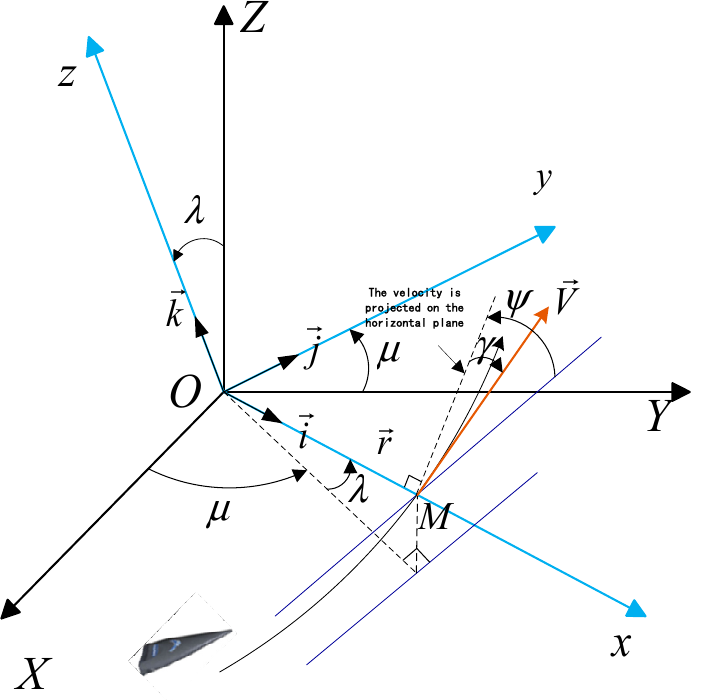
Figure 1. Coordinate system relationship. O is geo-center, O − XYZ is the geocentric earth fixed coordinate system, and O − xyz is the aircraft position coordinate system.